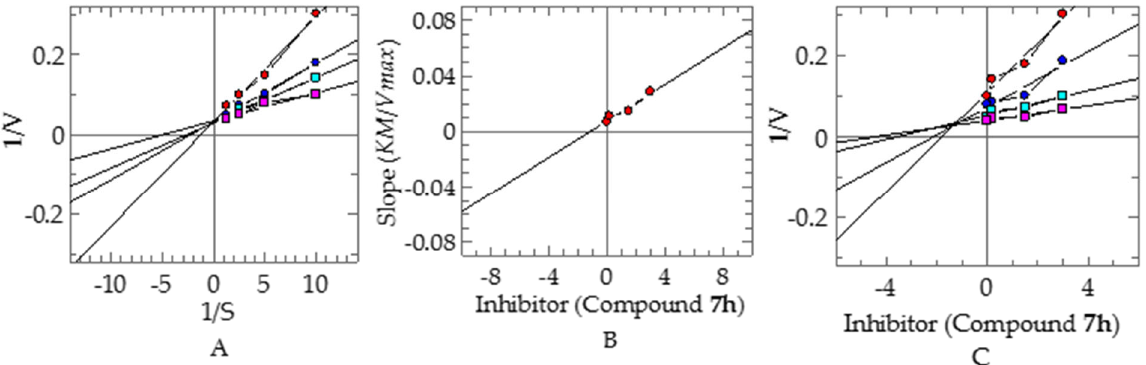
Figure 4. Mode of inhibition of α -glucosidase by compound 7h ( A ) Lineweaver–Burk plot of reciprocal of rate of reaction (velocities) vs. reciprocal of substrate p-nitro phenyl- α -D-glucopyranoside in the absence of ( ■ ), and in the presence of 3.00 ( ● ), 1.50 μ M ( ● ), and 0.1875 μ M ( ■ ) of compound 7h . ( B ) Secondary replot of Lineweaver–Burk plot between the slopes of each Lineweaver–Burk plot vs. different concentrations of compound 7h . ( C ) Dixon plot of reciprocal of rate of reaction (velocities) vs. different concentrations of compound 7h .